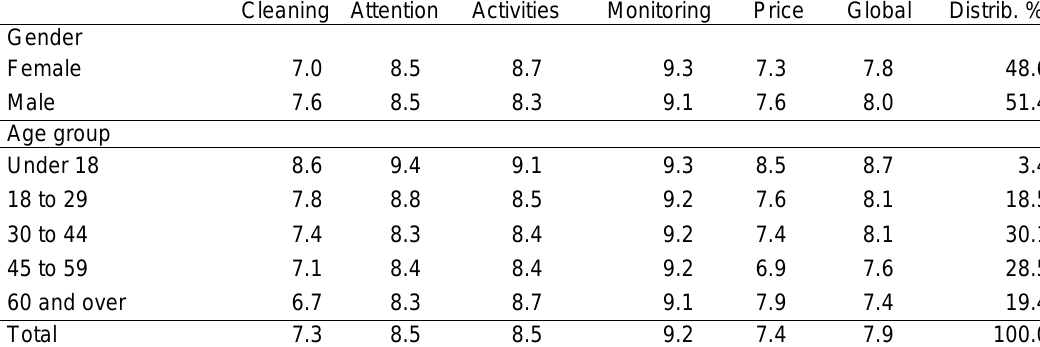
Table 16. Assessment of sports facilities by gender and age group (2017). Bellvitge sports facility. Cleaning